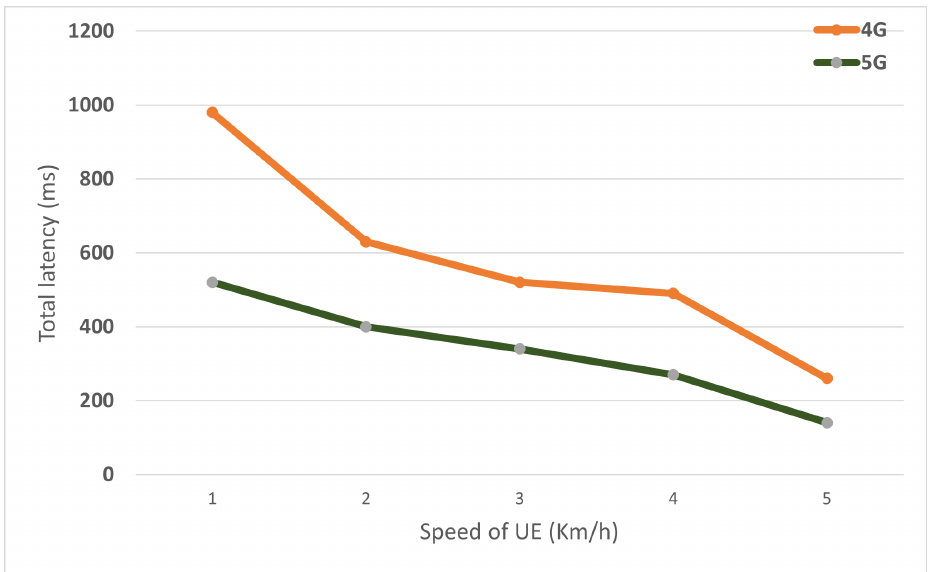
Figure 14. Comparison of 4G and proposed 5G in terms of latency of initial attachment.